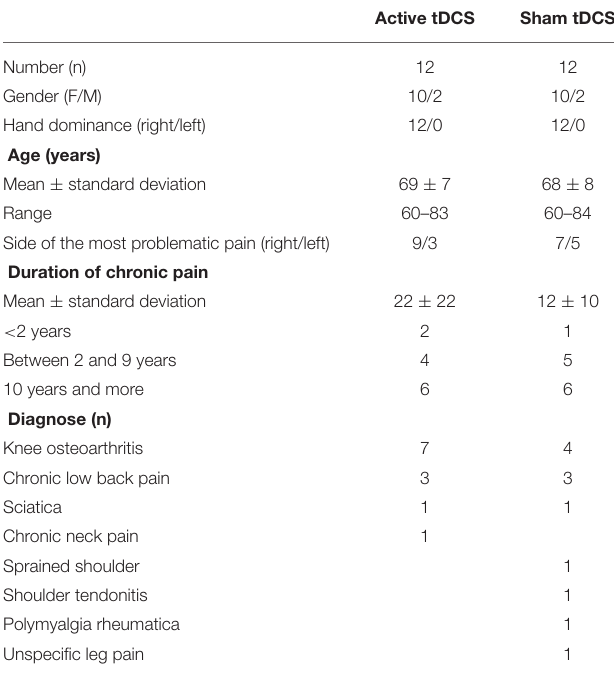
TABLE 1 | Clinical and demographic characteristics of the participants.